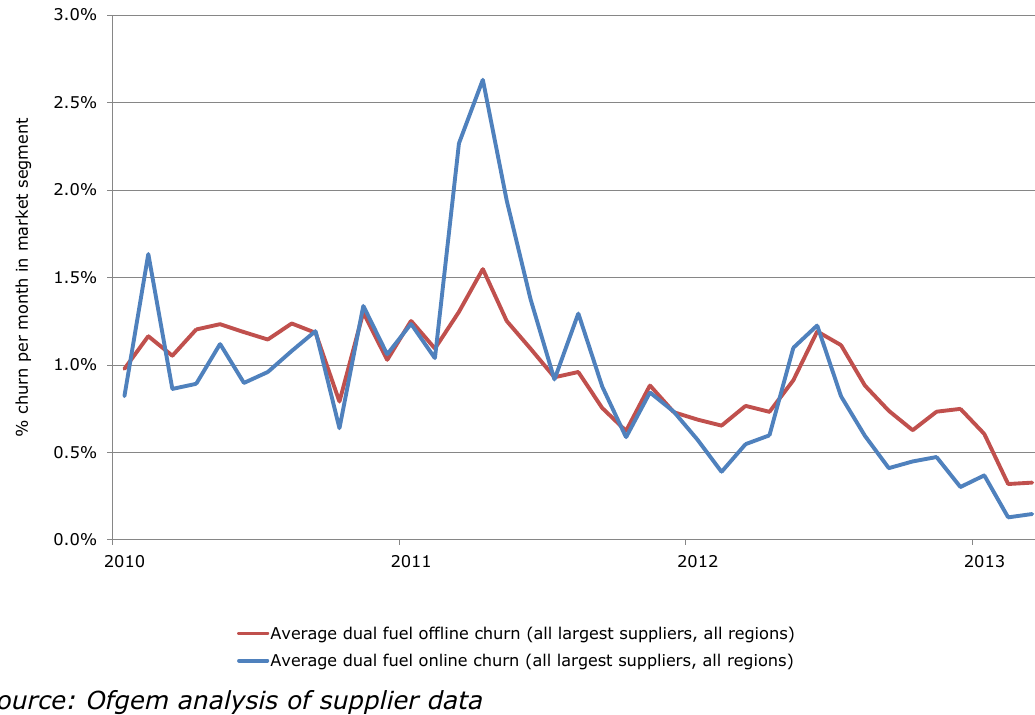
Figure 27: Largest suppliers’ churn for standard and online dual fuel